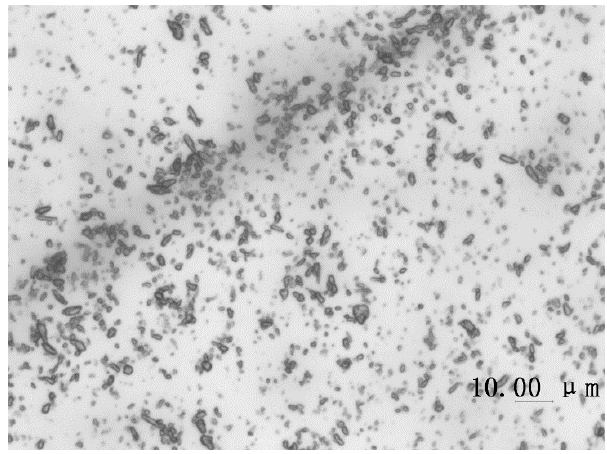
Figure 4. Microphotographs of naphthol AS-LC dispersed in cyclohexane.